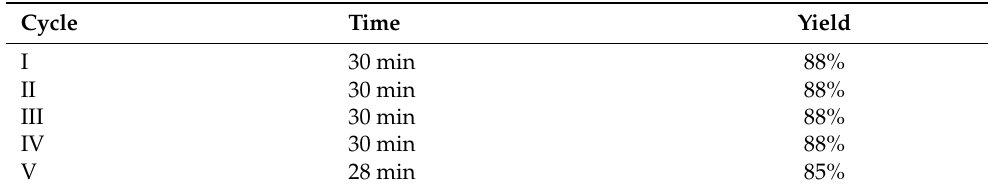
Table 2. Recyclability data of chitosan